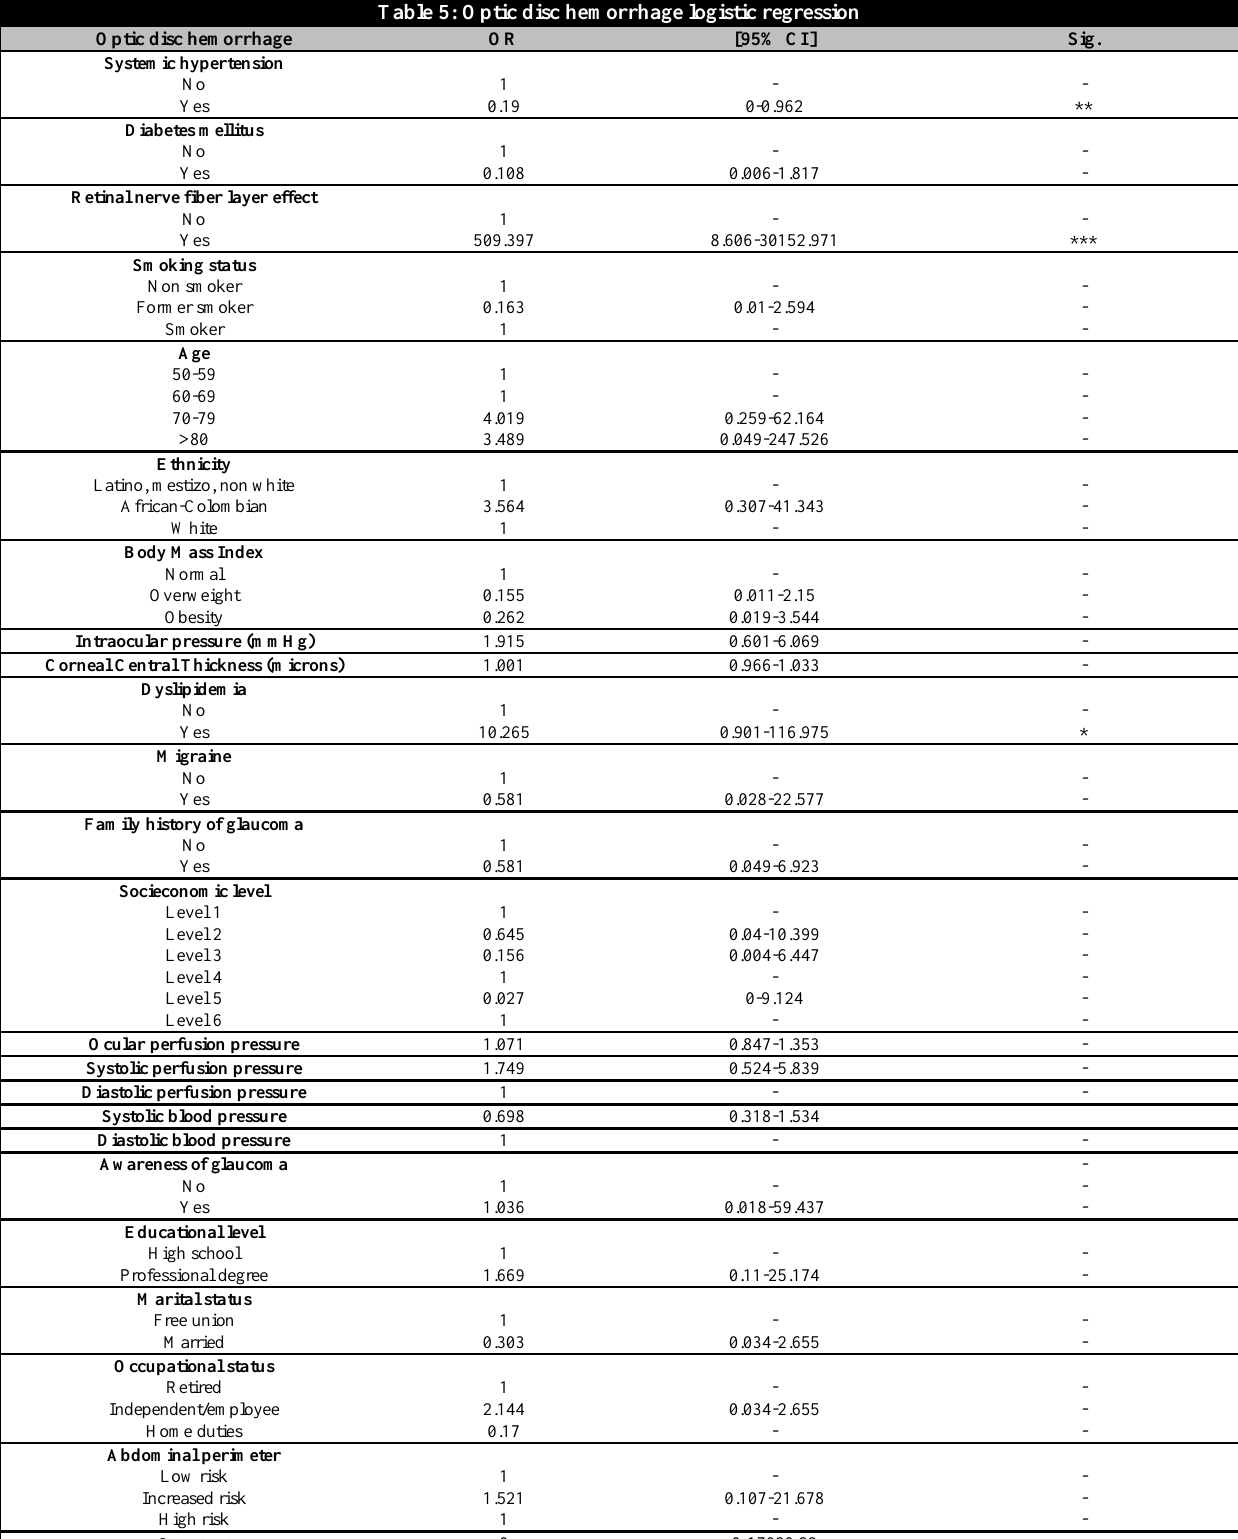
Table 5: Optic disc hemorrhage logistic